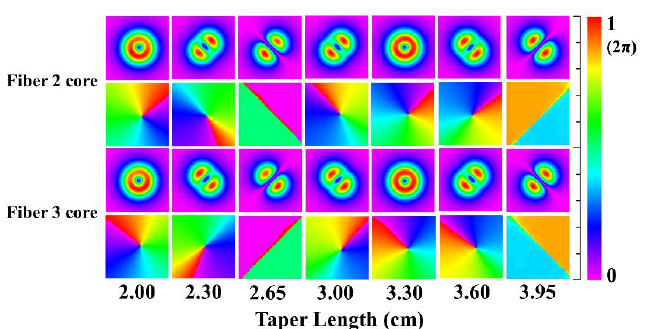
Figure 4. The BPM simulation output mode profiles of the PLs with different taper lengths when selectively injecting light into the Fiber 2 and 3 cores. selectively injecting light into the Fiber 2 and 3